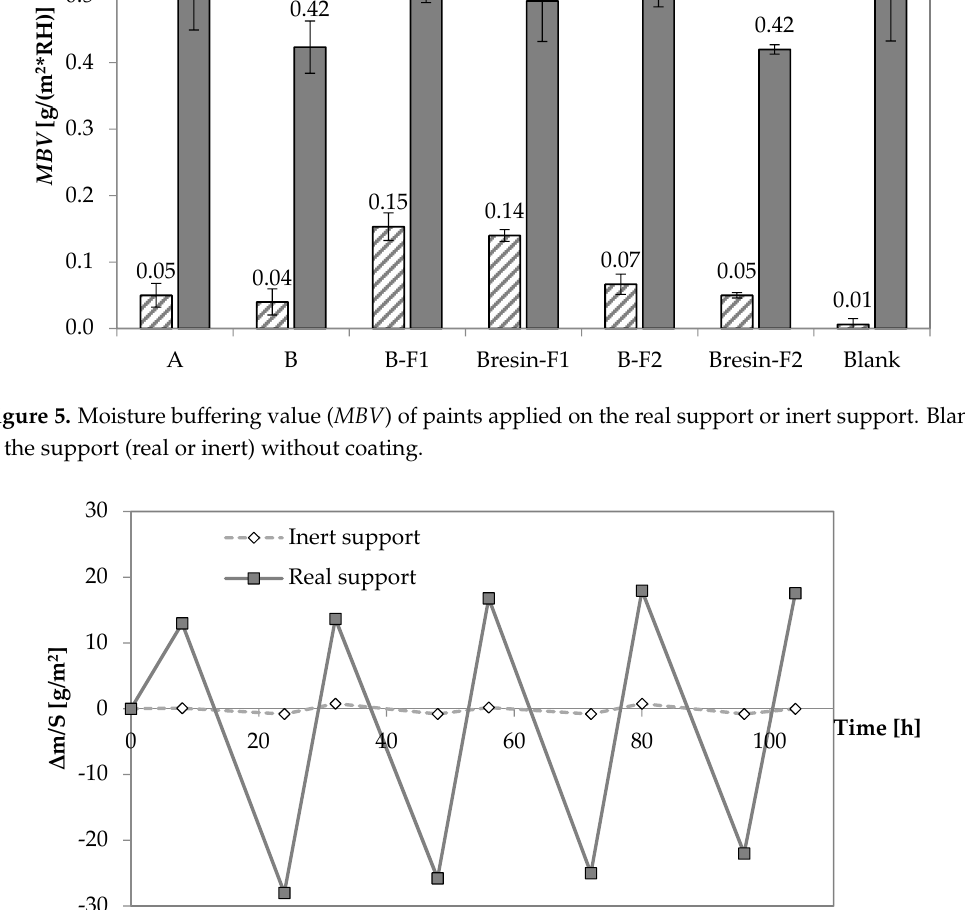
Figure 6. Change in water vapor content Δ m of real (mortar) and the inert support normalized on the exposed surface S.